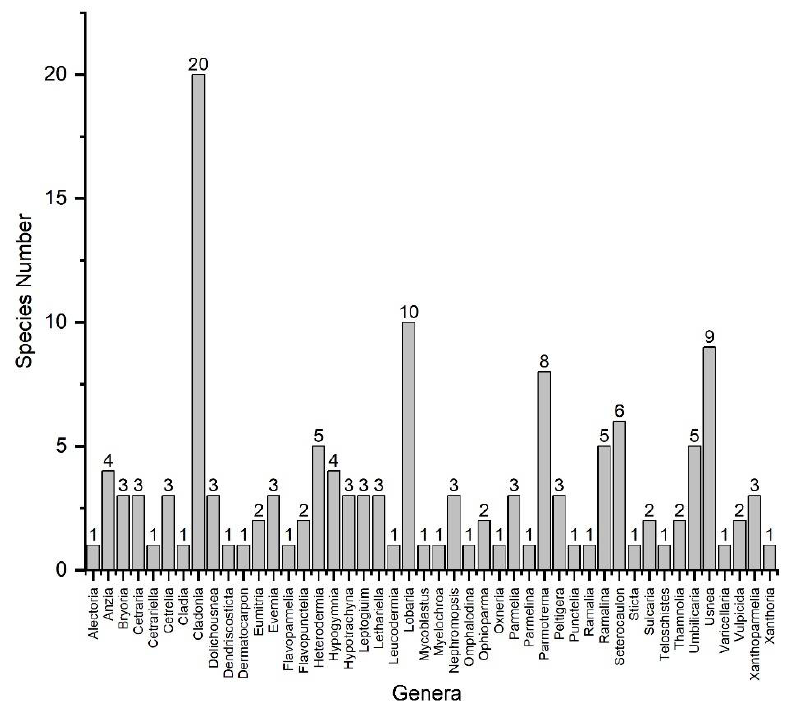
Figure 3. Species number within the different genera of traditional medicinal lichen. Table 1. Lichen species used in traditional medicine or herbal medicine in the Himalayas and southwestern parts of China. The newly added ones through our investigation are indicated in boldface.